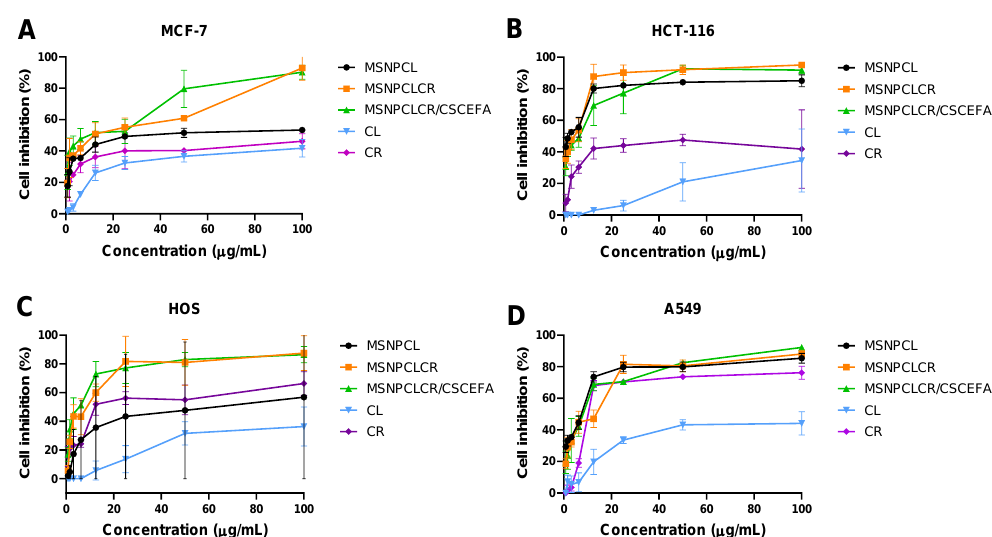
Figure 6. The anticancer evaluation of nanoformulations compared with free CL and CR against cancer cells treated at different concentrations ( µ g/mL) incubated for 48 h. ( A ) MCF7 breast cancer cells, ( B ) HCT-116 colon cancer cells, ( C ) HOS bone cancer, and ( D ) A549 lung cancer cells. Data are presented as mean ± SD. The concentration was prepared for nanoformulations as an equivalent concentration of CL and CR in nanoformulation equal to free CL and CR. Table 2. IC50 (µg/mL) of free natural agents and nanoformulations against different cancer cell lines. Treatments Cancer Cell